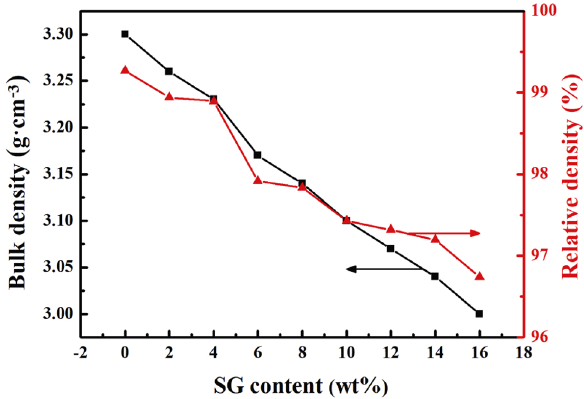
Fig. 5 Bulk density and relative density of SG/AlN composites with different SG